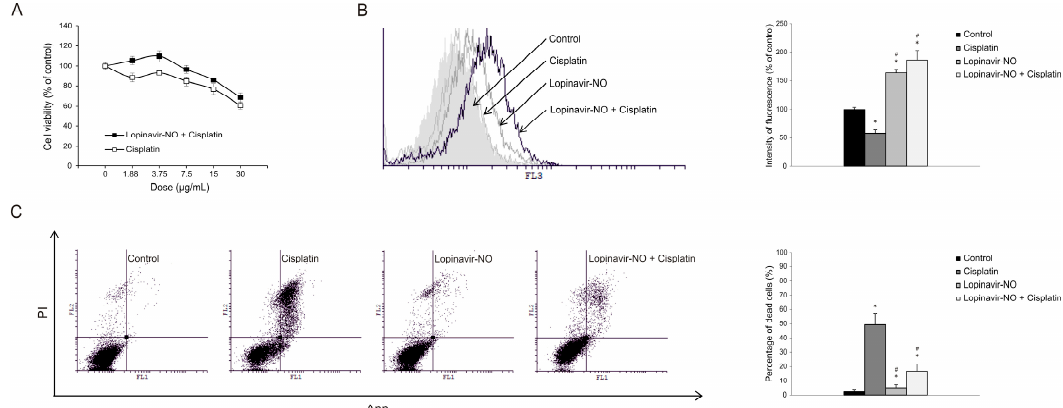
Figure 6. Lopi-NO antagonized Cisplatin toxicity in LN-229 cells. Cells were exposed to Cisplatin in the presence of IC 50 value of Lopi-NO and ( A ) cellular viability by CV test, ( B ) autophagy by acridine orange staining, and ( C ) apoptosis by AnnV/PI staining were performed. * p < 0.05 in comparison tocontrol, # p < 0.05 in comparison to Cisplatin. Representative results of flow cytometry (B, C, left) and charts of three independent experiments (B, C, right) are